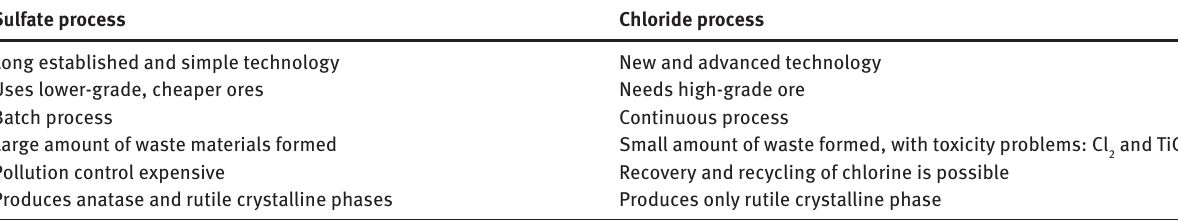
Table 2: Comparison of the sulfate and chloride processes. Sulfate